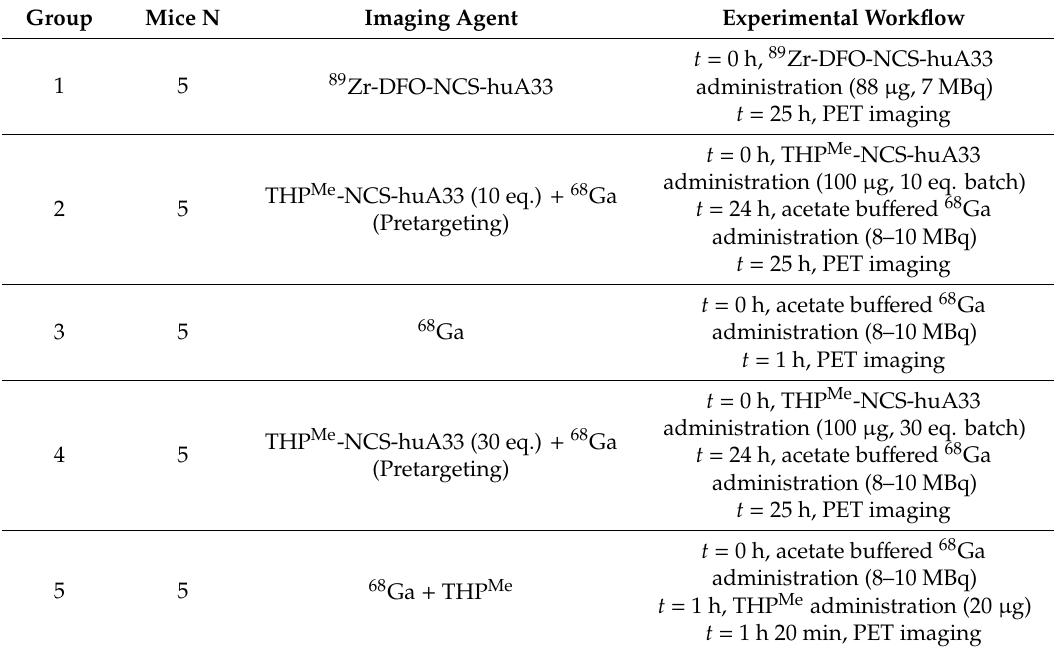
Table 1. Groups considered for in vivo pretargeting